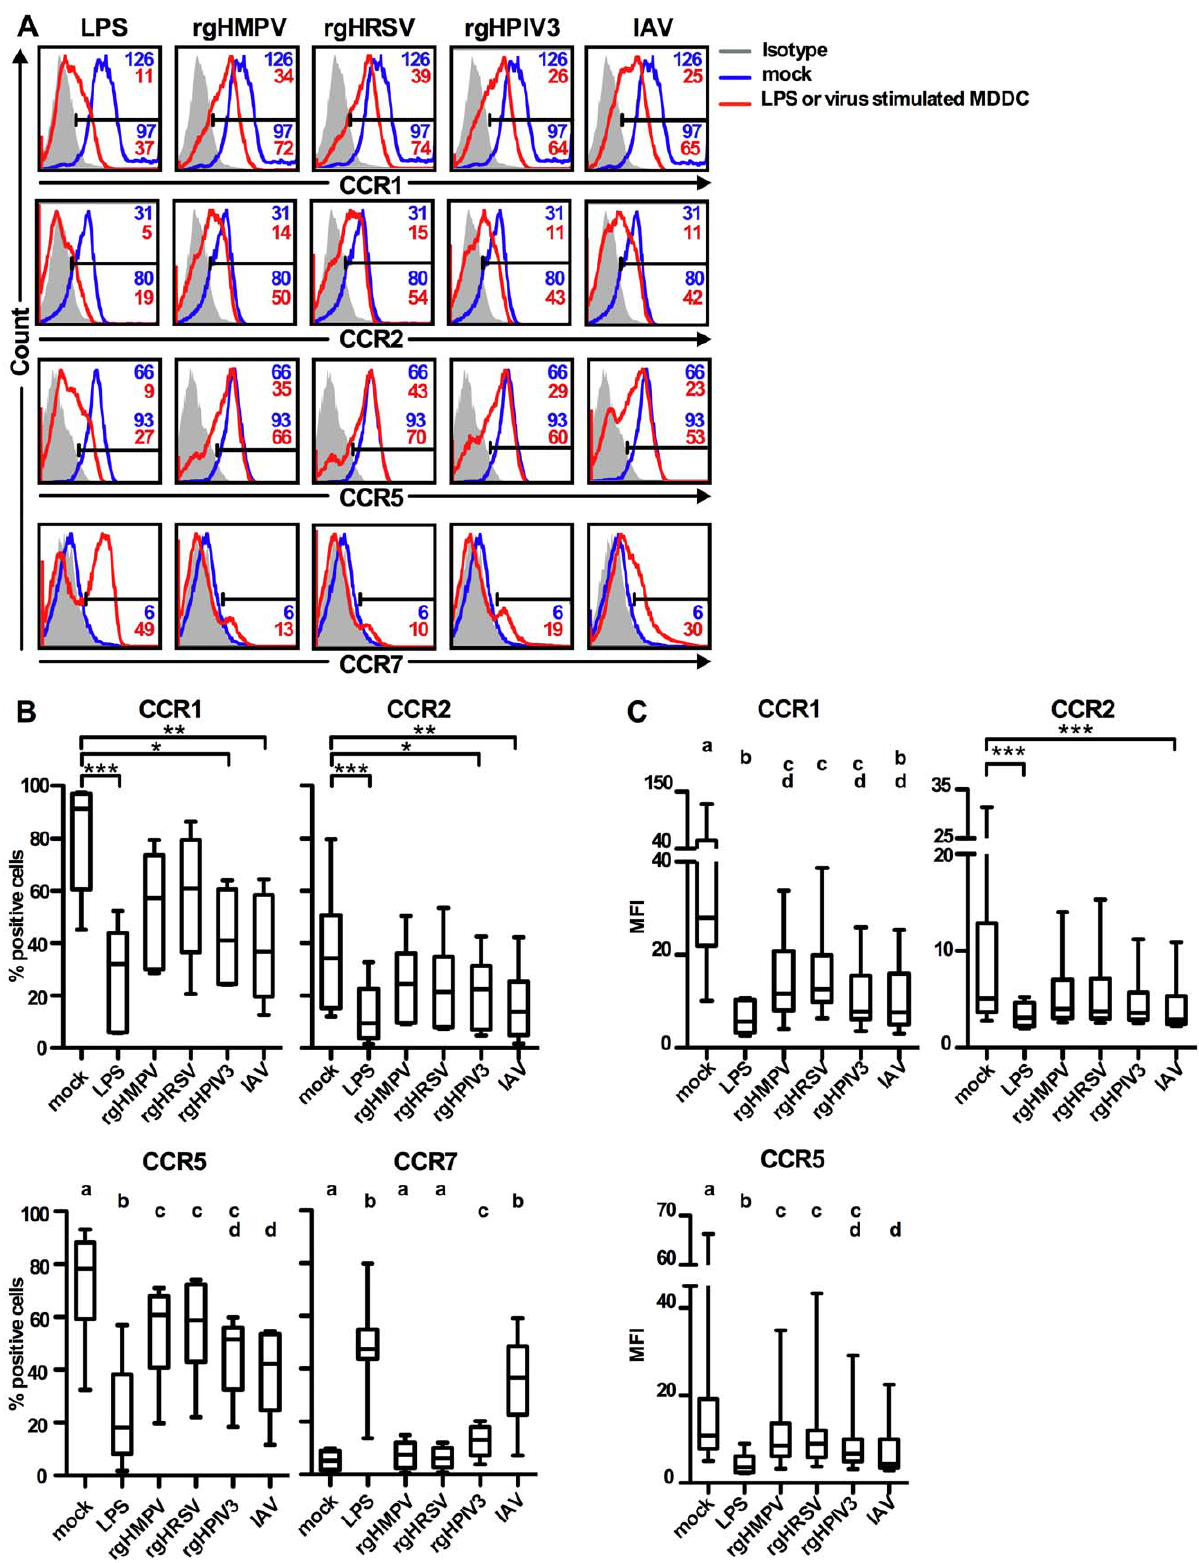
Figure 2. Cell surface expression of the chemokine receptors CCR1, 2, 5 and 7. Immature MDDC were stimulated with LPS or infected with rgHMPV, rgHRSV, rgHPIV3, or influenza/A/Udorn (IAV) at an MOI of 3 PFU/cell. 48 h post-infection, the surface expression levels of CCR1, 2, 5 and 7 were assessed by flow cytometry. (A) Surface expression of CCR1, 2, 5, and 7 from a representative donor. The MFI (top right corner) and % positive (bottom right) of each cell population are indicated for each histogram, with red indicating the treated population and blue indicating the mock-